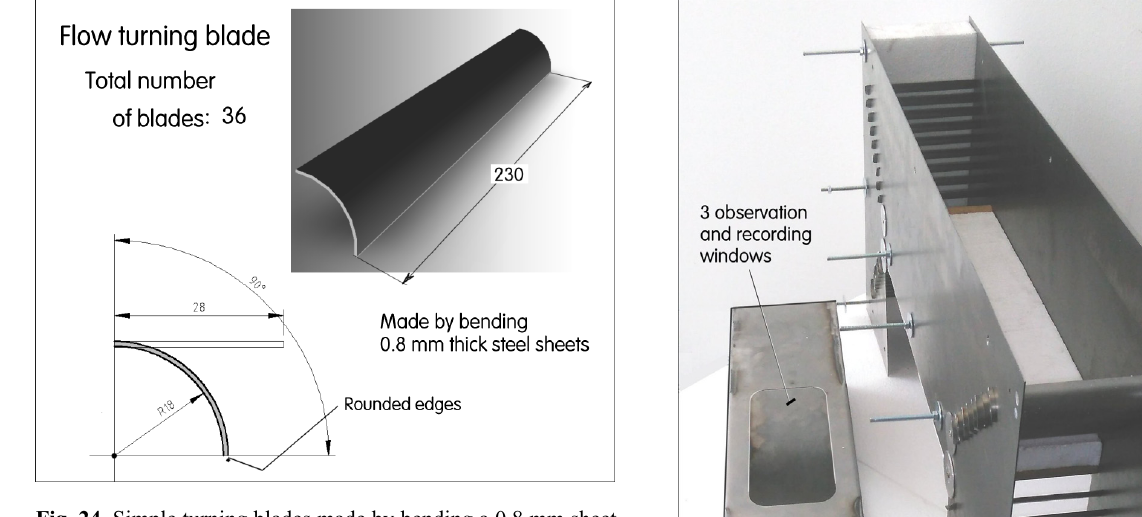
Fig. 24. Simple turning blades made by bending a 0.8 mm sheet metal rectangles, of constant thickness with rounded leading edge.